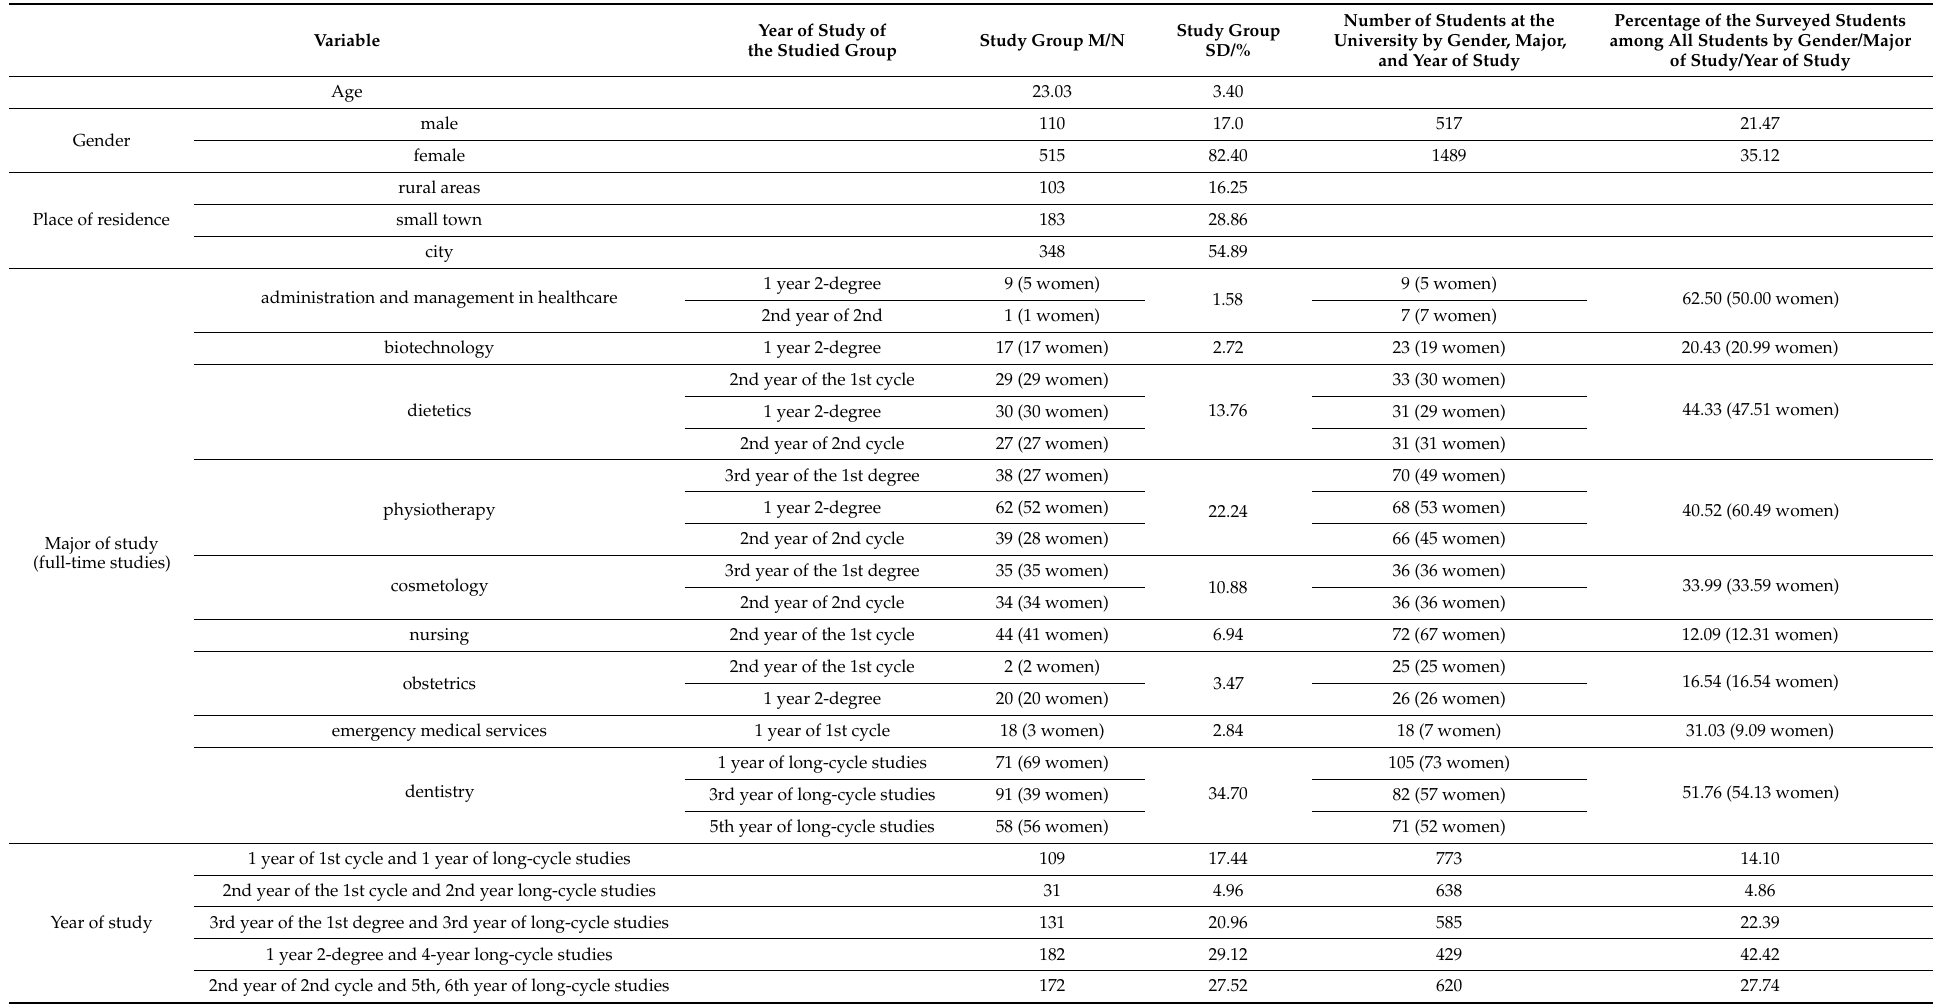
Table 1. Sociodemographic characteristics of the sample (N =